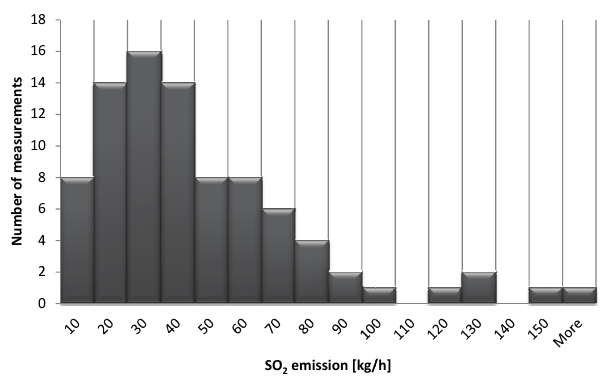
Fig. 9. Histogram of all SO 2 emission measurements by DOAS in the North Sea campaign. A relatively large number of small ships were measured close to the harbour; these were found to emit about 20kgh − 1 SO 2 . Many of the ocean-going vessels had an emission of about 60kgh − 1 SO 2